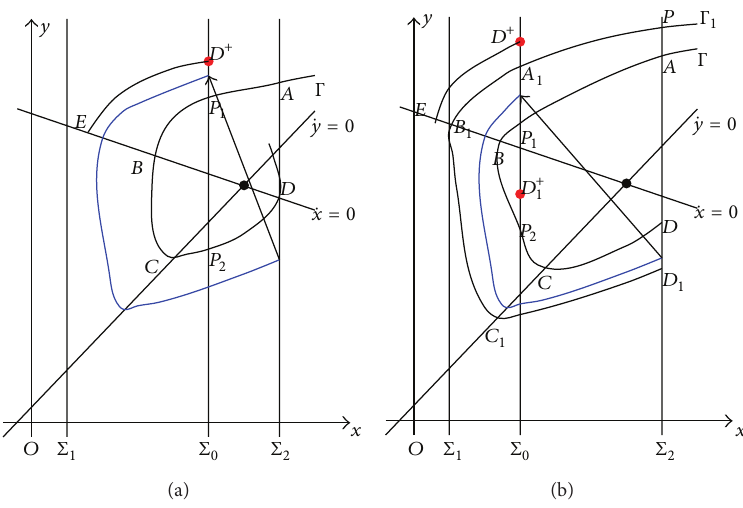
Figure 5: The possible trajectories in the case of ℎ 1 < 𝑥 𝐵 < (1 − 𝛼)ℎ 2 < 𝑥 ∗ < ℎ 2